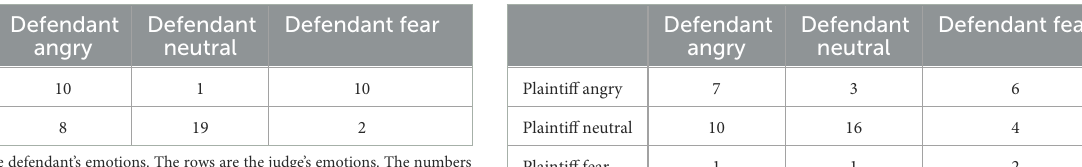
TABLE 1 The influence of judge’s emotion on defendant’s emotion.